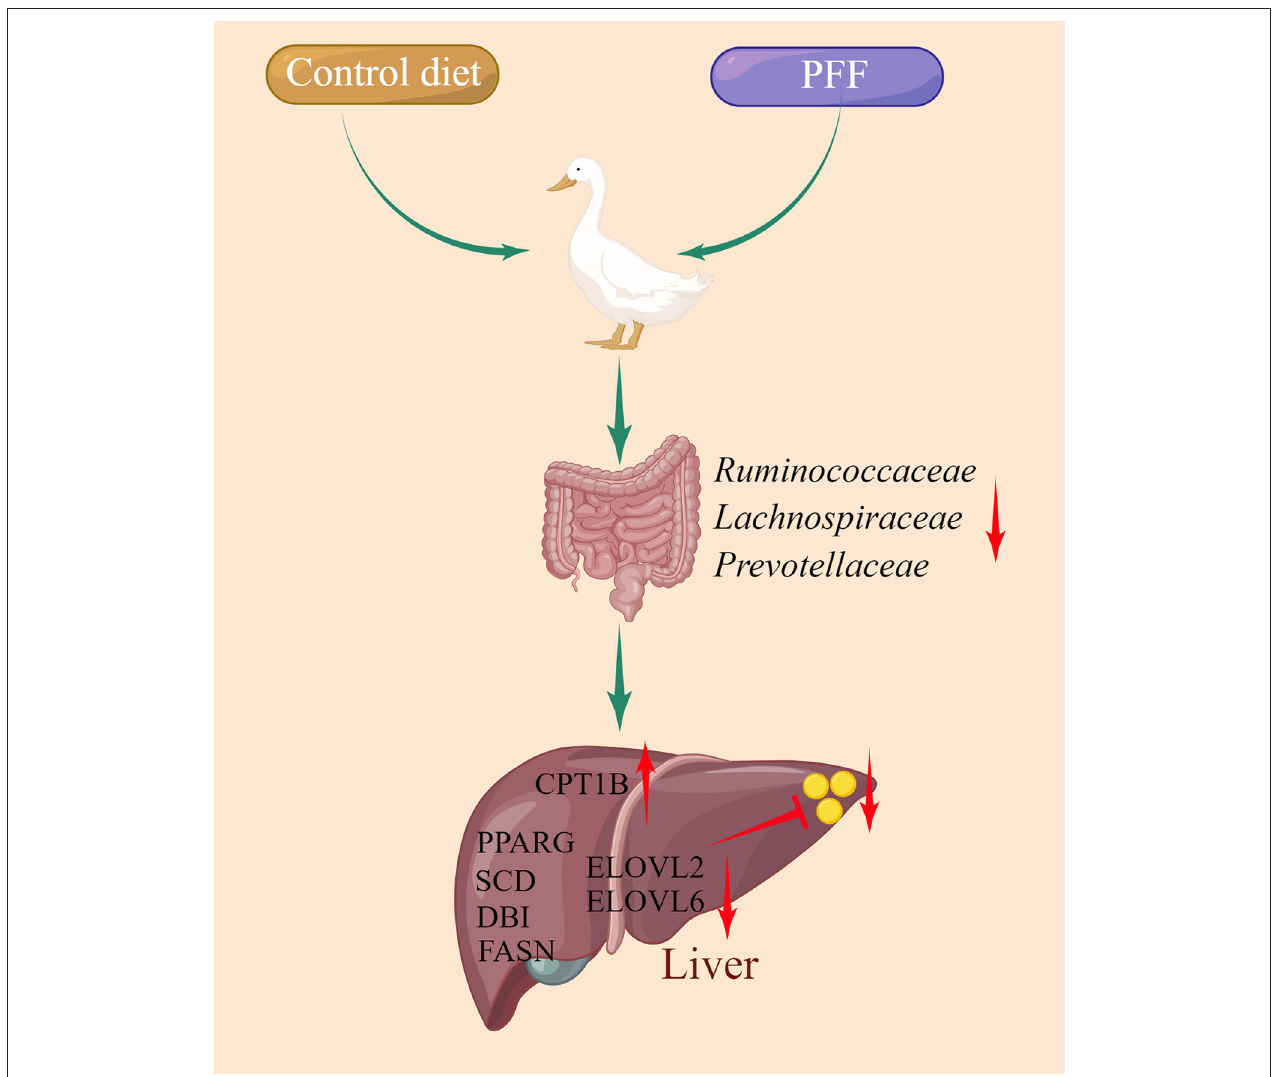
FIGURE 6 | A model depicting use of PFF to alleviate liver fat deposition by targeting gut